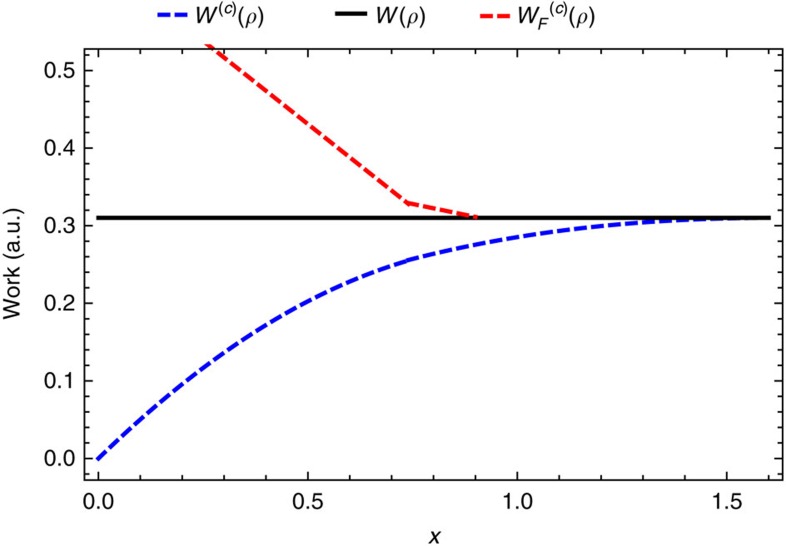
Variation of c-bounded work extraction and state formation further from equilibrium as a function of c for fixed states.Figure shows (ρ) and W(c)(ρ) versus c for the trit state  with Hamiltonian  with , . β is set to 1. For small c the dissipation |W(c)(ρ)−W(∞)(ρ)| for the formation protocol is greater than for the extraction protocol, and for large c the relationship is inverted. Note that for c>0.9 it possible to thermodynamically reversibly prepare state ρ but not to thermodynamically reversibly extract work from it.